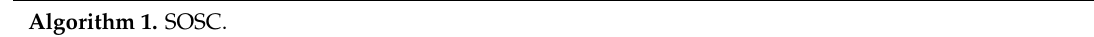
Algorithm 1. SOSC.